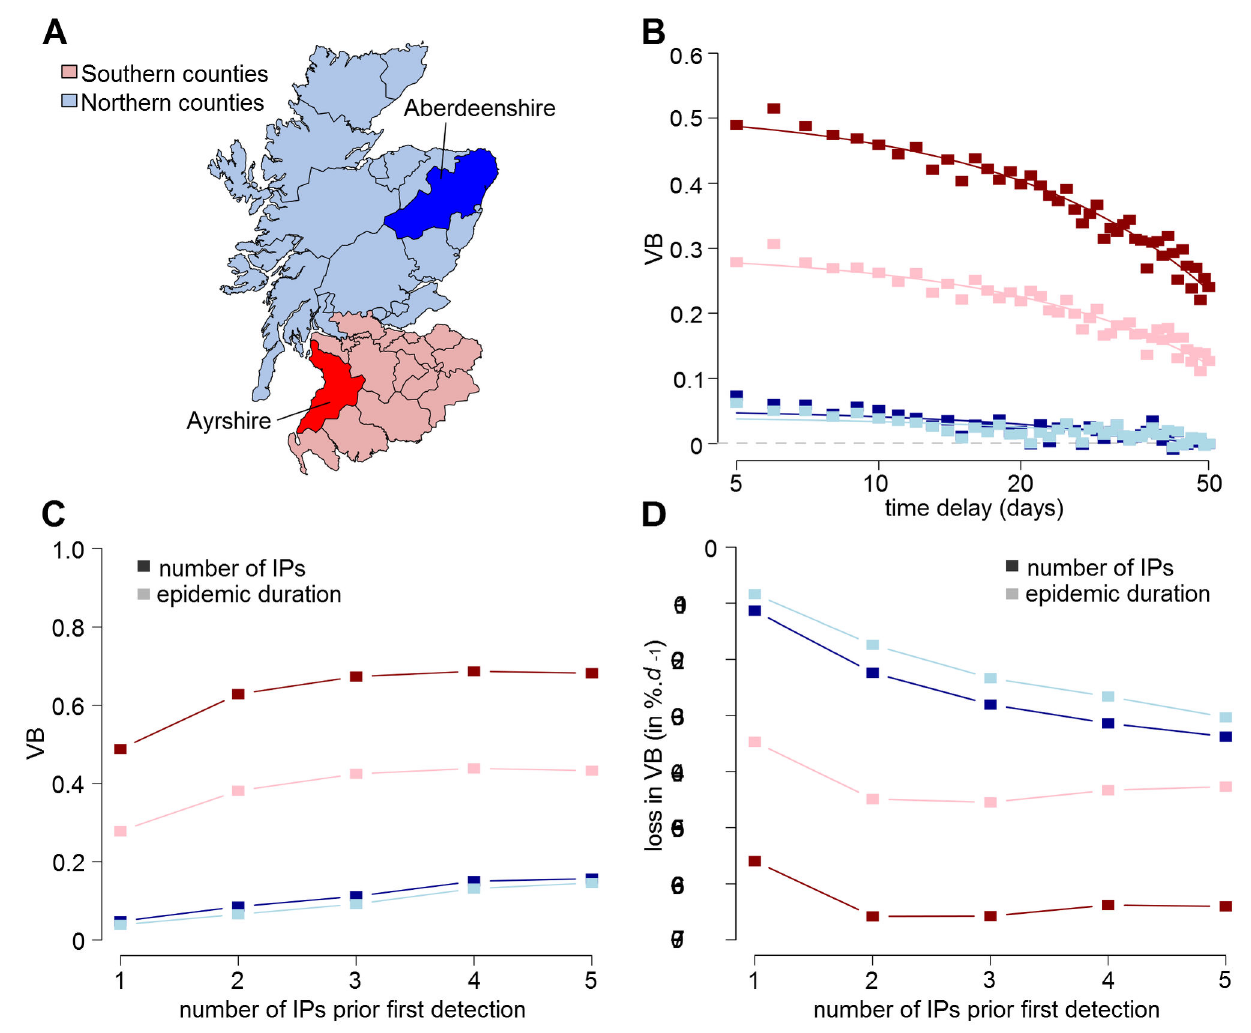
Figure 5. Resilience of vaccination benefit to delays in field implementation. (A) Map showing the location of Aberdeenshire and Ayrshire as examples for the different dynamics identified in Scotland. (B) Effect of delaying the implementation of vaccination in the field on its benefit (VB) for epidemics generated from a single premise in Ayrshire (red) and Aberdeenshire (blue). (C) Risk ratio in VB for each infected premise (IP) increase prior to first detection. (D) Variations in the rate of VB loss for each day increase in delaying its implementation in the field. Values of VB in B, C and D were computed over the number of IP (dark symbols) and the duration (light symbols) of generated epidemics. The probability of severe epidemics was defined as the probability of epidemics either showing >100 IPs (dark symbols) or lasting >60 days (light symbols). Grey dashed line in B indicates the null benefit. Note that x-axis in B are in